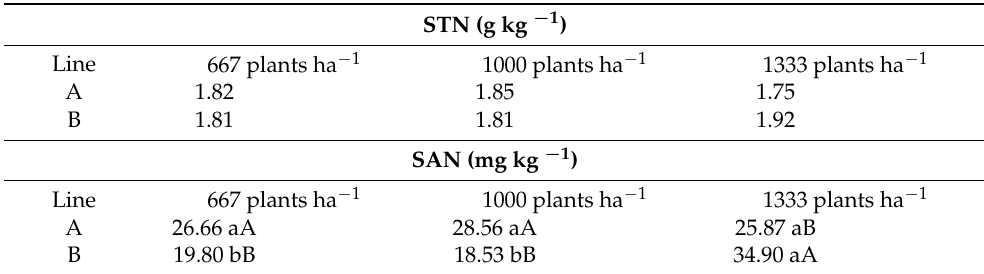
Table 4. Soil total (STN) and available nitrogen (SAN) from agrisilviculture systems with 667, 1000 and 1333 plants of Gliricidia sepium ha − 1 . Soil samples were collected at lines close to the G. sepium plants (A) and in the middle of the plots (B) and at the 0.00–0.20 m soil